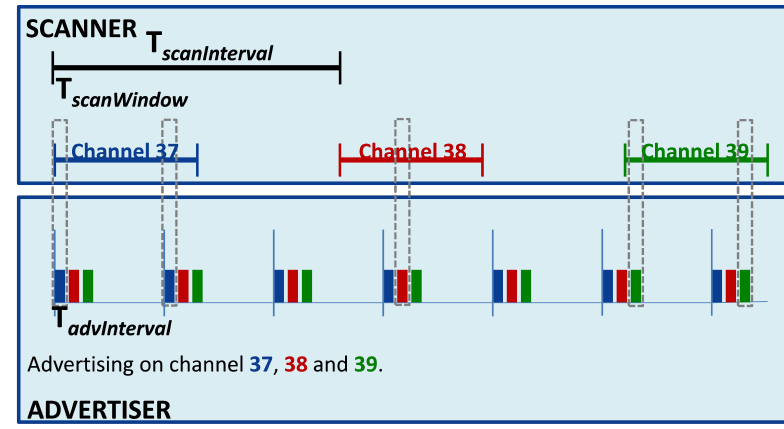
Figure 6. This figure shows how the advertising and scanning mechanisms work. In the upper part is shown the scanner ; it scans on the three advertising channels (37, 38, 39, colored respectively in blue, red and green), switching the scanning channel within a period called T scanInterval . The effective scanning period, per each channel, lasts for a time called T scanWindow . On the other hand, the advertiser , shown in the bottom part of the Figure, sends a burst of three advertising packets, one for each advertising channel, with a specific period (T advInterval